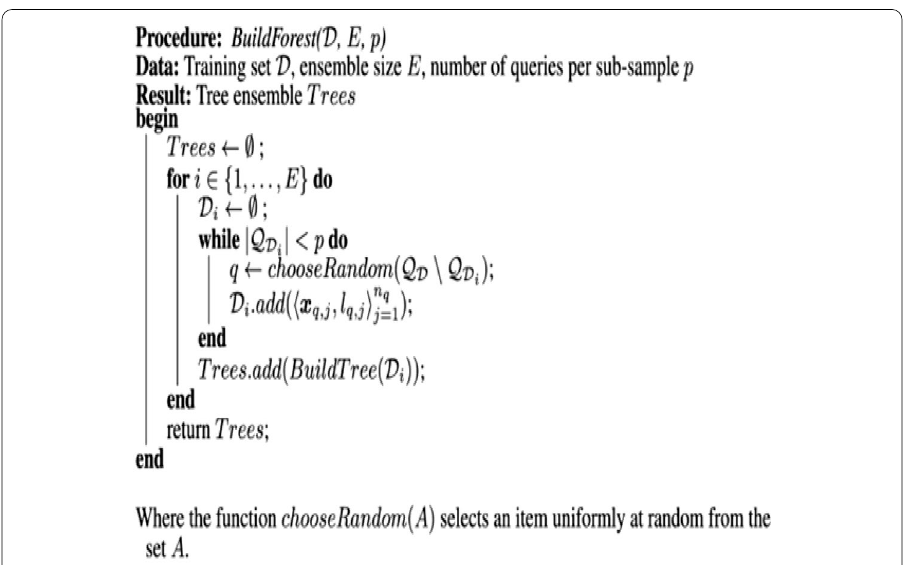
Fig. 14 The proposed model based on random forest